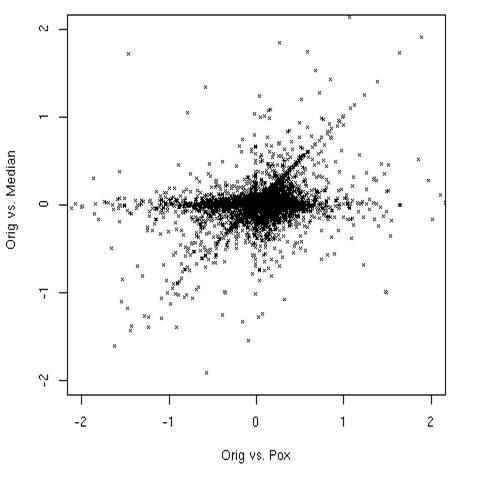
Restoration effects. Comparing the log fold changes in the MAS5 algorithm before and after restoration. Vertical axis, log fold change between the original expression values and the restored values (Orig vs median). Horizontal axis, log fold change between the original and blemished chips (Orig vs pox). Notice three straight lines through the plot. A diagonal line represents changed expression values that were not restored by Harshlight. A vertical line shows a few cases in which Harshlight incorrectly affected the expression values. Most points lie near the horizontal axis, showing that Harshlight restored values closer to the original.